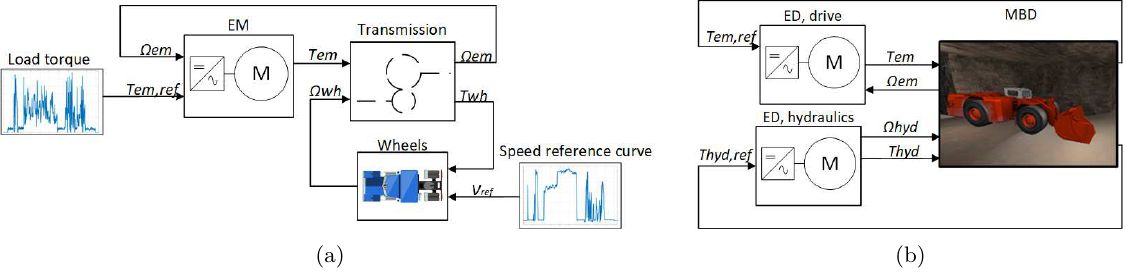
Figure 8: Simulation principle of series HEV for a) recorded loading cycles and b) for MBD